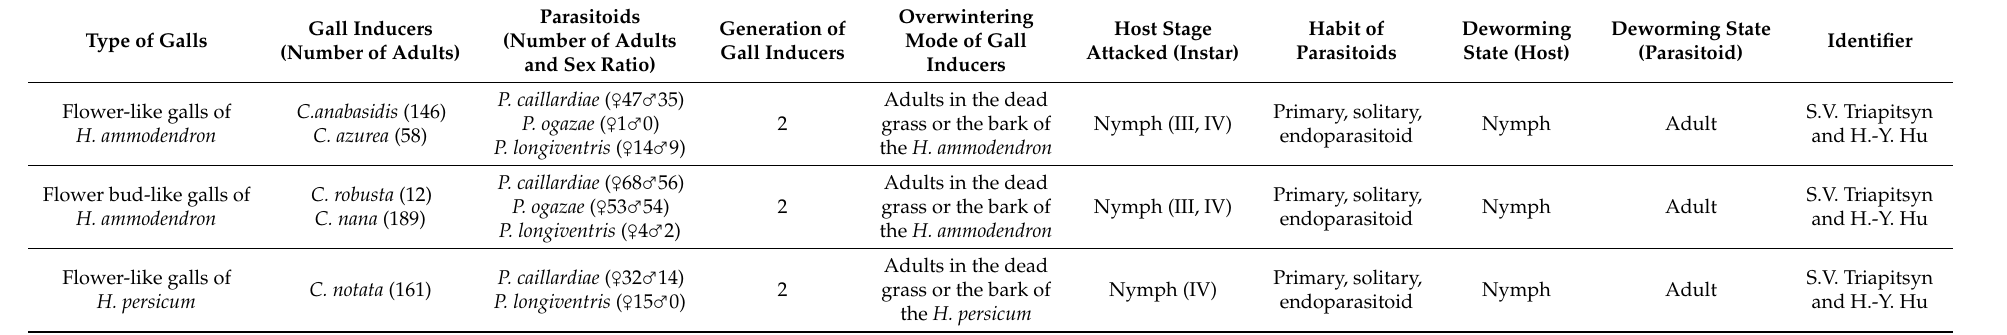
Table 2. Parasitoids and their hosts of flower-like galls on Haloxylon in 2018.